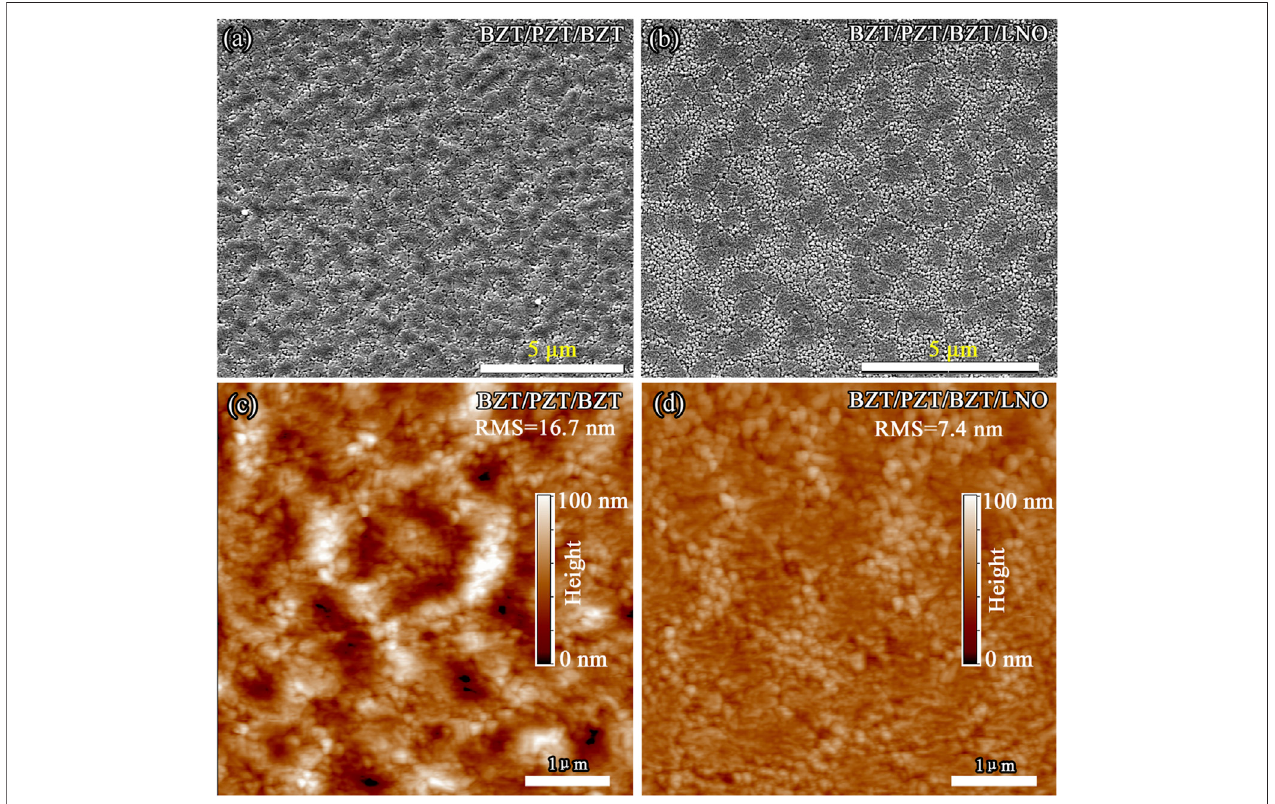
FIGURE 2 | Surface morphology images of the BZT/PZT/BZT and BZT/PZT/BZT/LNO thin fi lms. (A, B) SEM images; (C, D) AFM images.